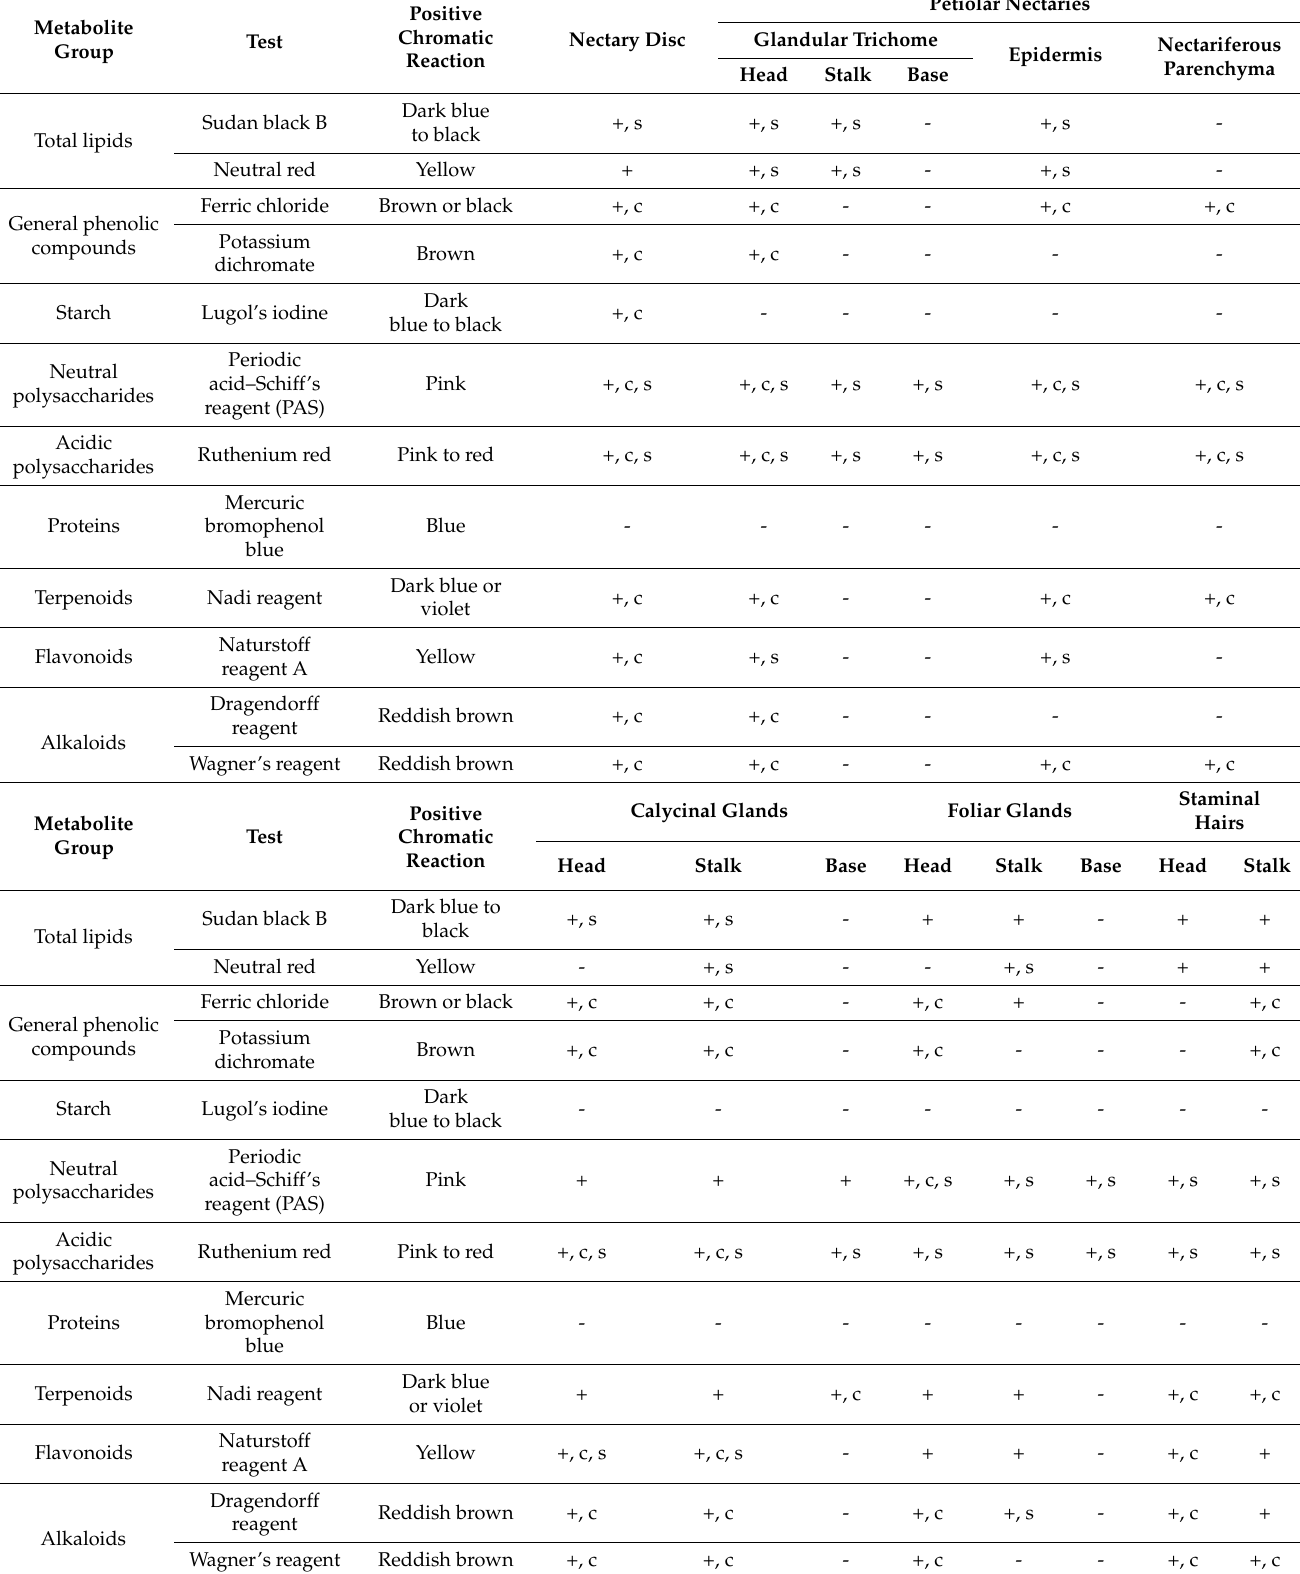
Table 1. Metabolites identified in secretory structures of Rivea ornata using histochemical